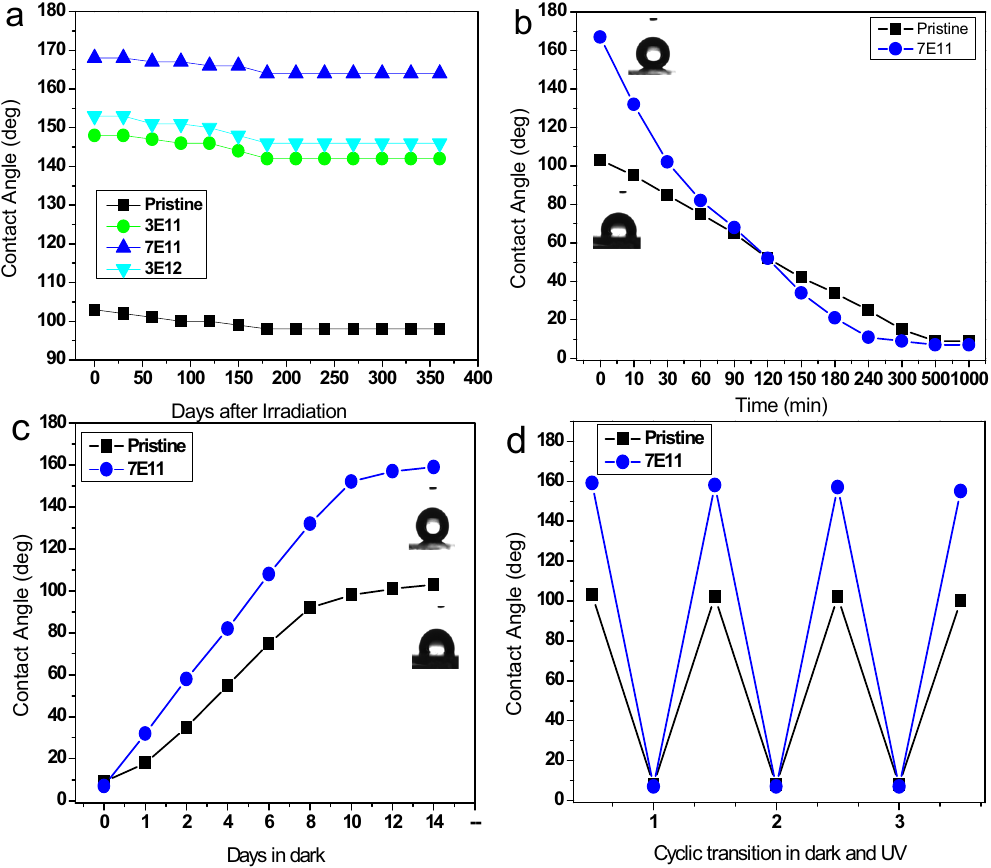
Figure 7. ( a ) Durability of the NR arrays for a period of one year. ( b ) Photoinduced water wettability transition from hydrophobic to hydrophilic in the ZnO NR arrays under UV illumination ( c ) water contact angle recovery in the dark-stored ZnO sample; Complete recovery to the initial state of superhydrophobicity is observed and ( d ) cyclic transition of water wettability with UV light illumination and dark storage. The pristine and irradiated ZnO NR arrays were subjected to UV light exposure and was stored in dark for a week before placing under UV illumination again.